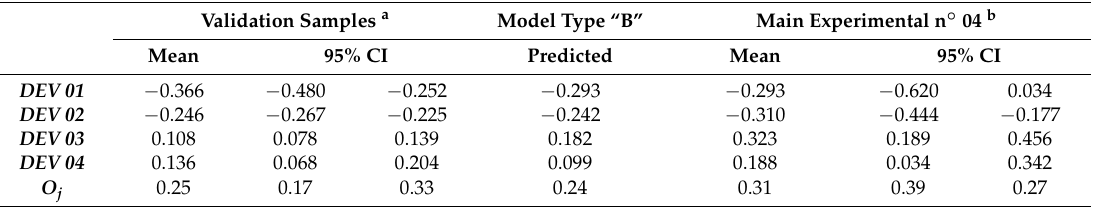
Table 9. Comparative results of the multi-criteria optimization model type